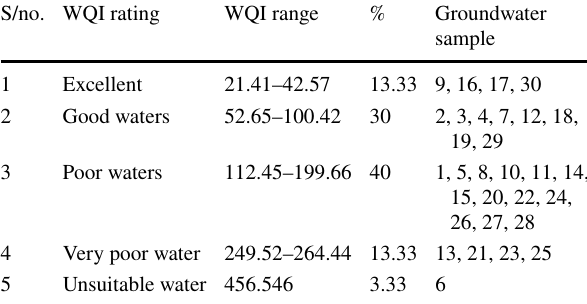
Table 5 WQI ratings and percentage composition S/no. WQI